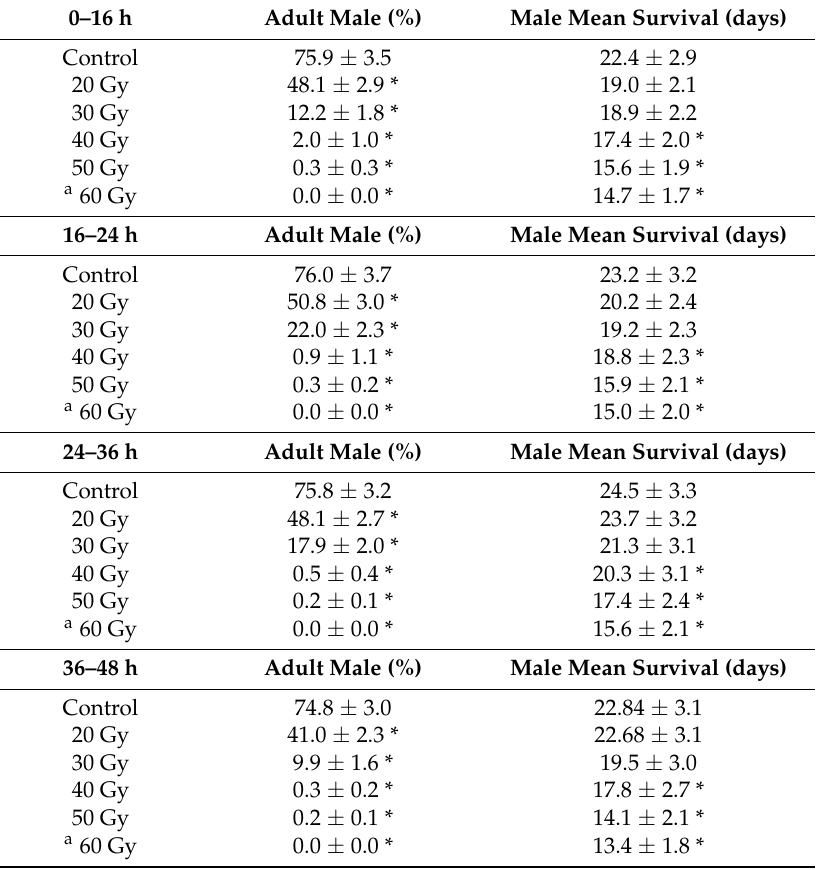
Table 2. Mean longevity of adult males and viable percentage of transformed pupae in adult males from irradiated pupae at various